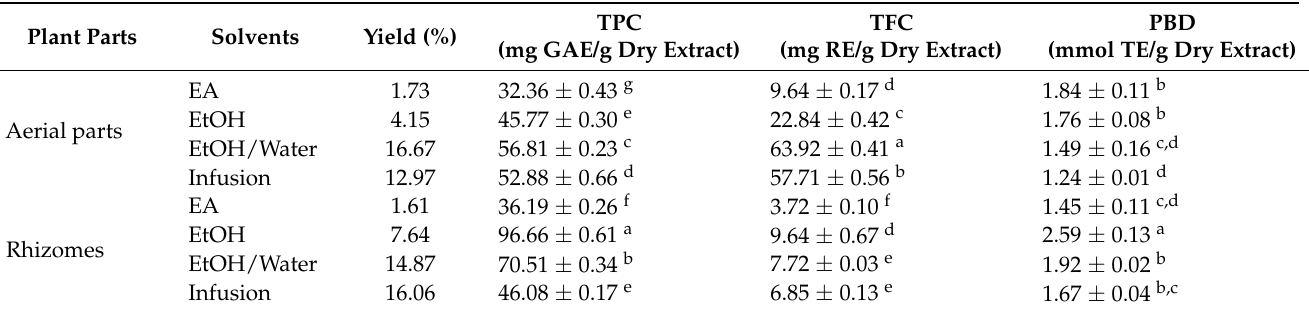
Table 1. Yield (%),total phenolic (TPC) and flavonoid (TFC) contents, and total antioxidant capacity (PBD) of the tested